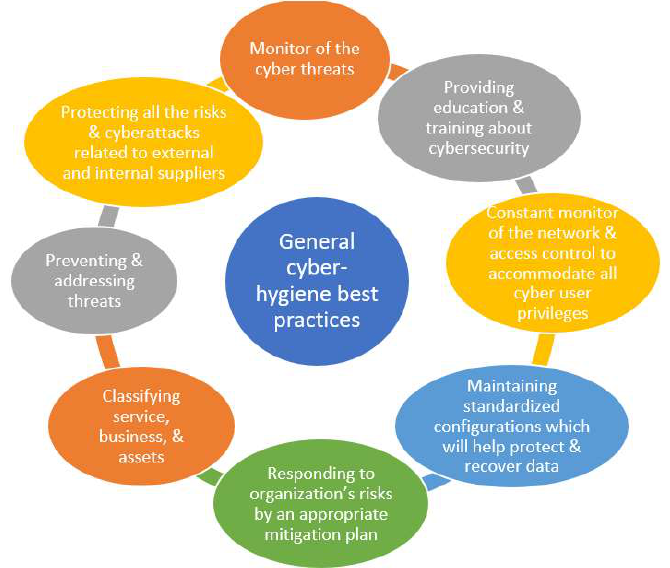
Figure 1. Best practices for general cyber hygiene.